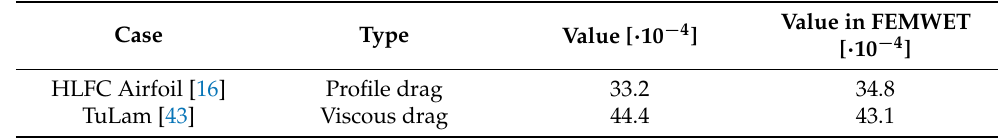
Table 4. Drag comparison for different test cases.